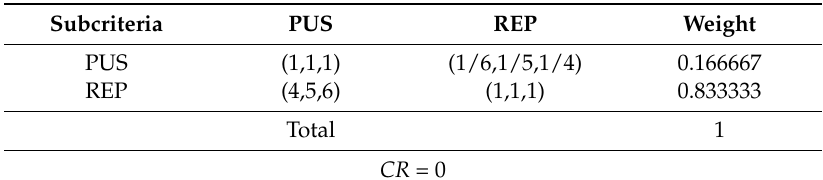
Table A14. Comparison matrix for EOP.